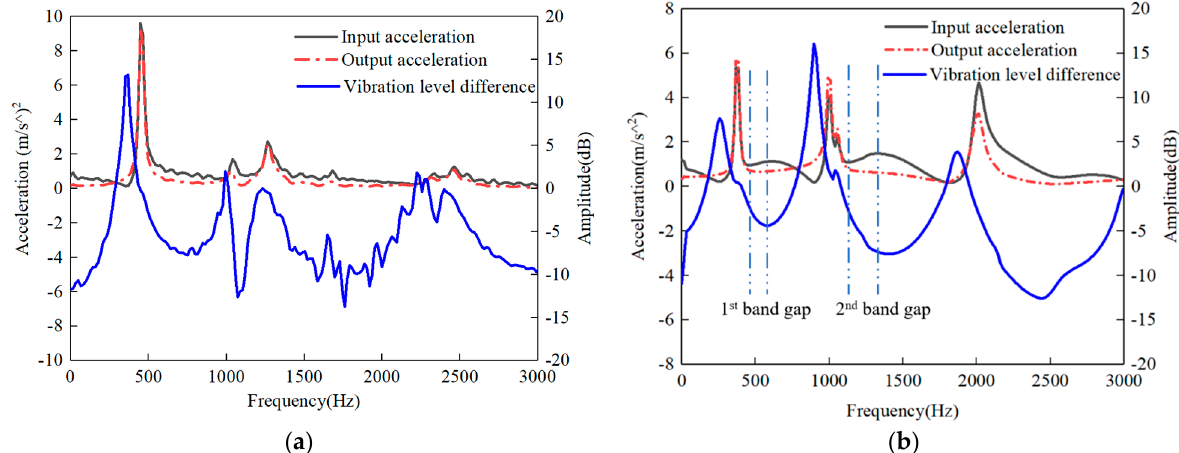
Figure 12. Frequency response curve obtained by experiment ( a ) traditional CFRP laminate ( b ) CFRP laminate with periodic structures.